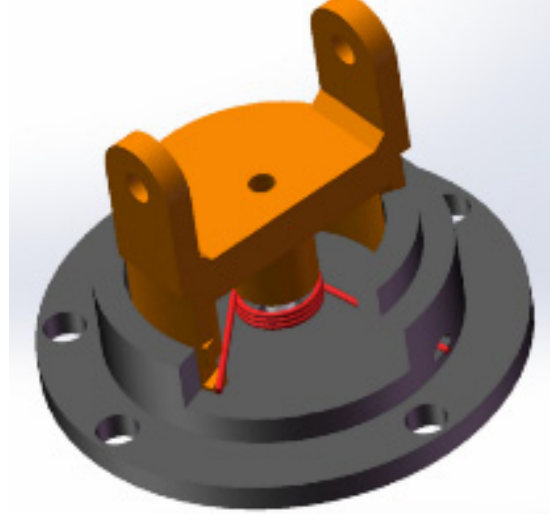
Figure 16. Finger branch adaptive structure.